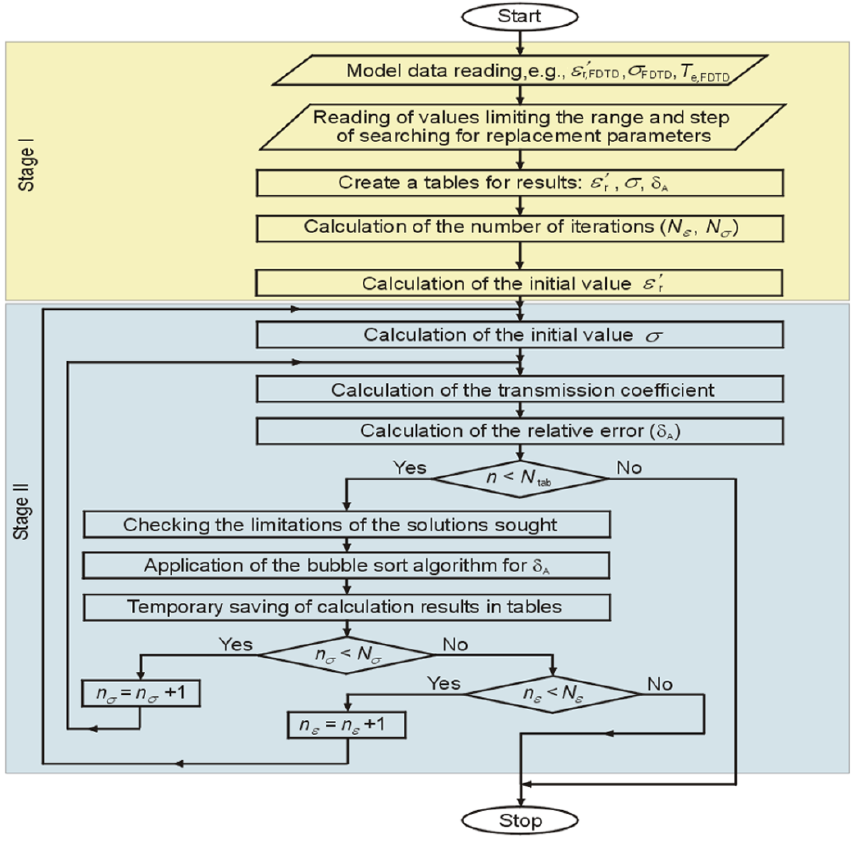
Figure 9. Diagram of the algorithm for the selection of effective electrical parameters.